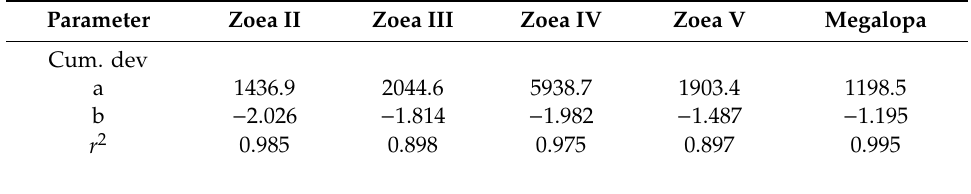
Table 3. Fitted parameters ( a, b ) and determination coe ffi cients ( r 2 ) of non-linear regression equations (power functions, y = a × T b ) describing the development time ( y, day) as a function of temperature (T, ◦ C). Cum. dev: cumulative time of development from hatching to later stages. Parameter Zoea